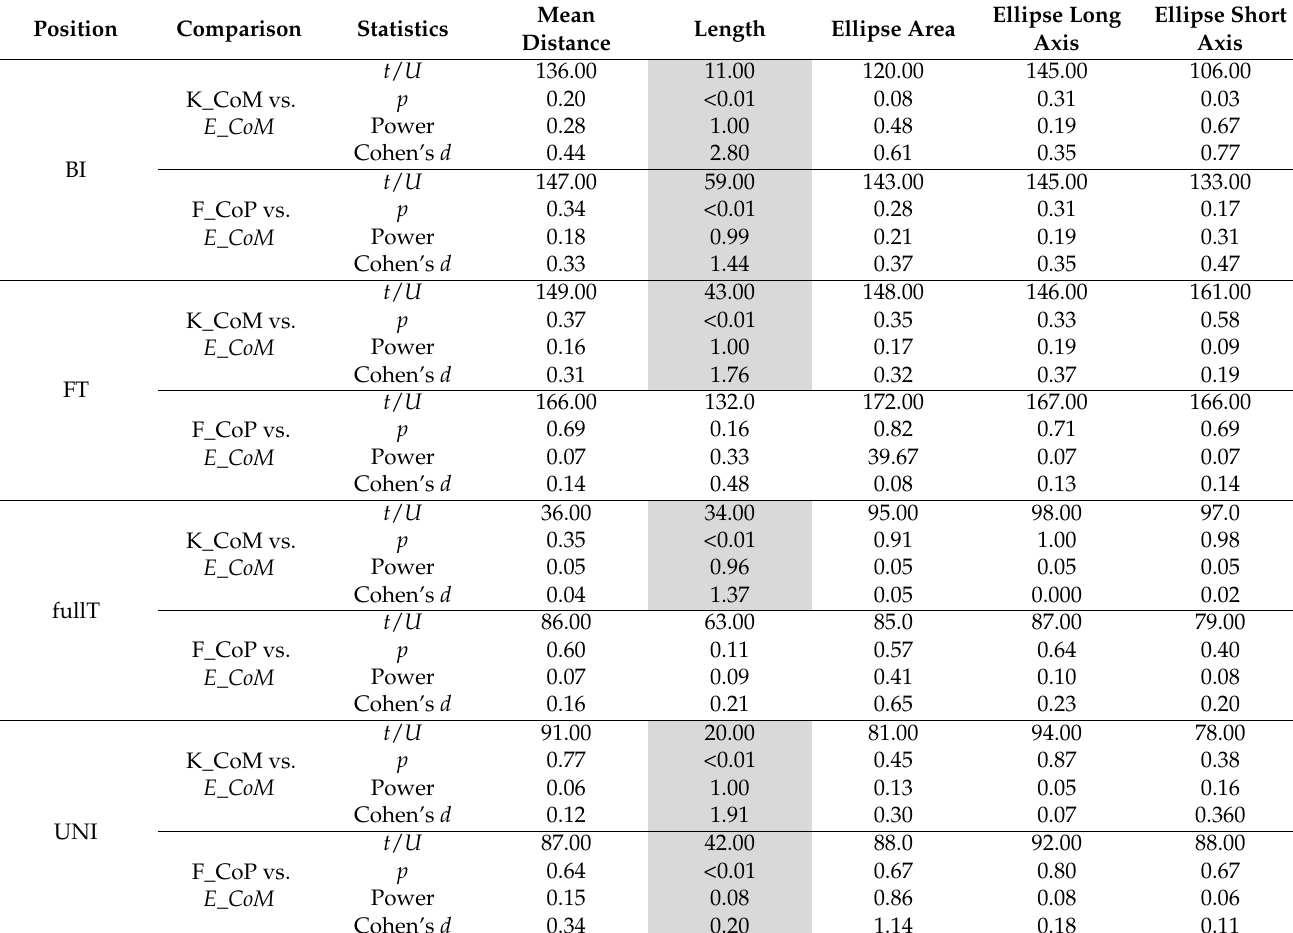
Table 7. Statistics results, power, and effect size for the comparison between Equimetrix CoM ( E _ CoM ) and the kinematic CoM (K_CoM) and force platform CoP (F_CoP) for two-dimension parameters.